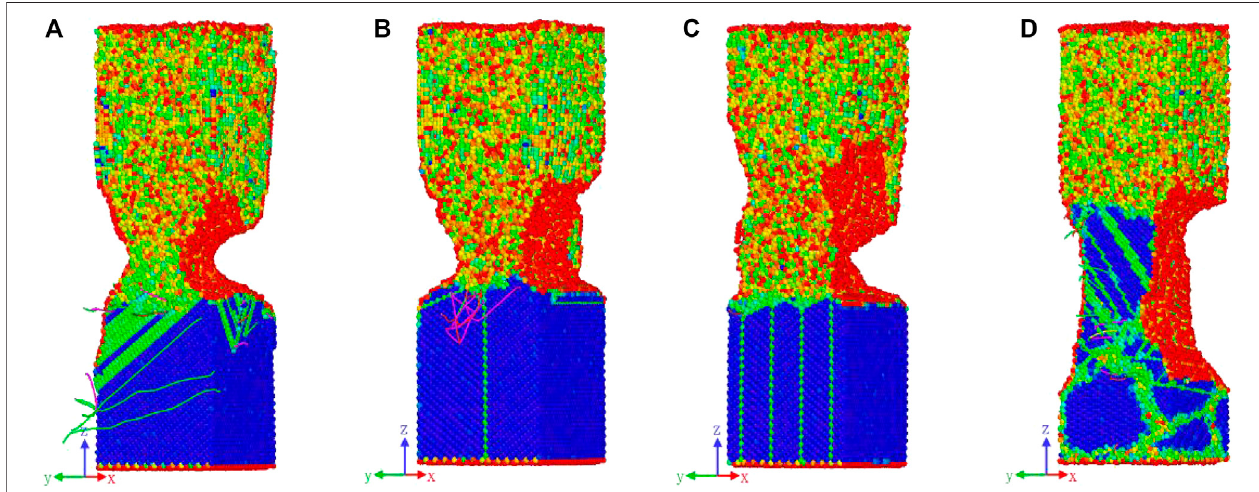
FIGURE 3 | CSP and DXA results at a displacement of 60 Å under a strain rate of 0.01% ps − 1 : (2A) single-crystal Cu, (B) twin-crystal Cu with one twin grain boundary, (C) twin-crystal Cu with four twin grain boundaries, and (D) polycrystalline Cu.